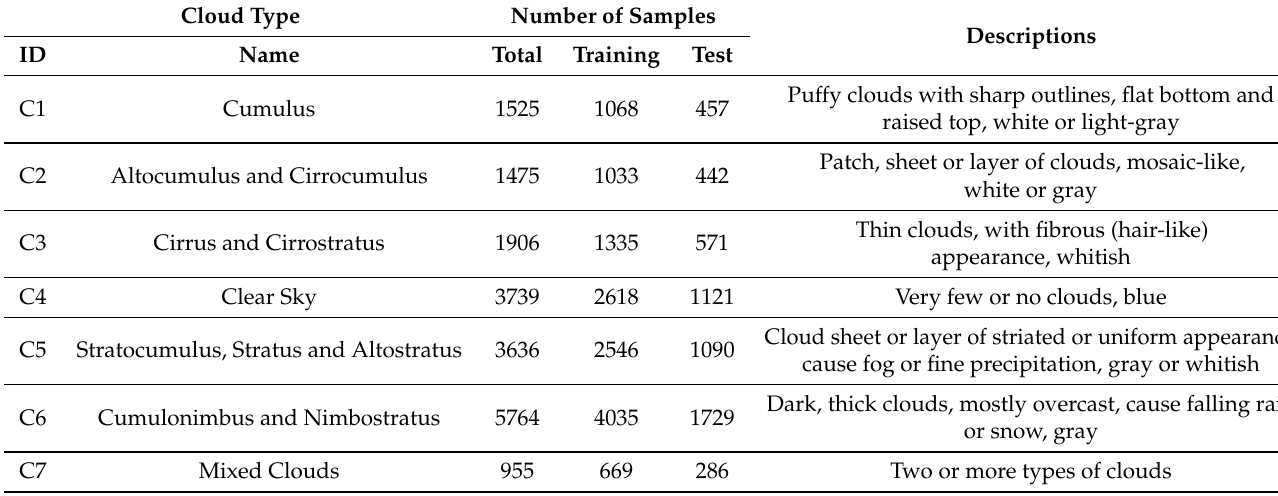
Table 1. Details of GCD